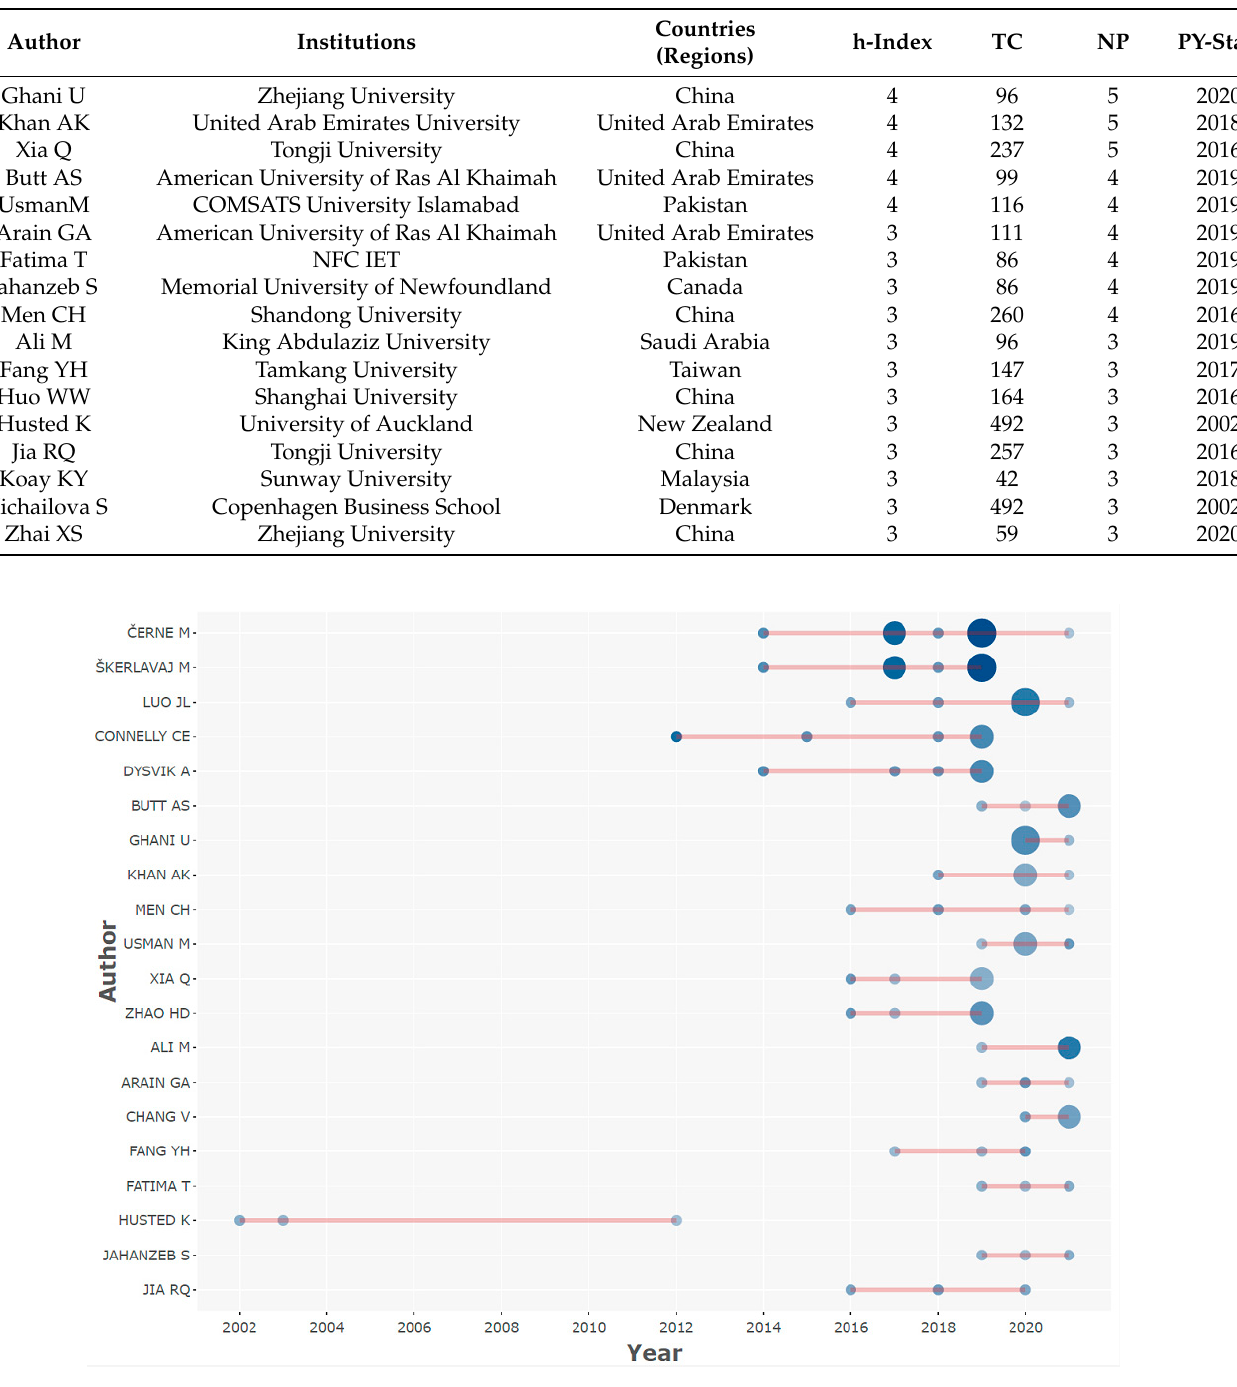
Figure 2. Top 20 authors’ productions over times in knowledge-hiding research field.